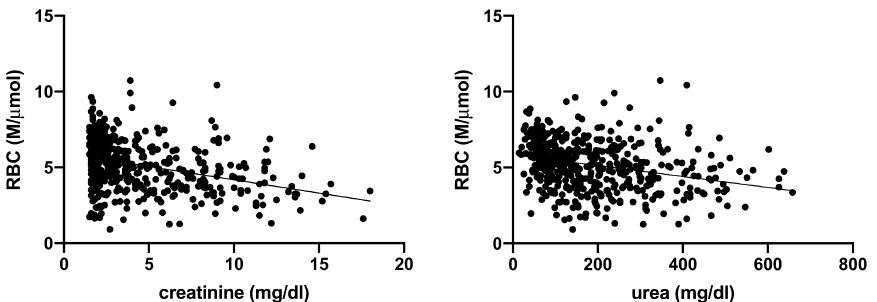
Figure 1. Spearman’s correlation analysis between RBC and serum creatinine and urea. Statistically significant, negative linear correlation ( p < 0.0001; r − 0.3470) between RBC (M/ µ mol) and serum creatinine (mg/dL), and statistically significant negative linear correlation ( p < 0.0001; r − 0.2840) between RBC (M/ µ mol) and serum urea (mg/dL) in the totality of anemic CKD dogs ( n =